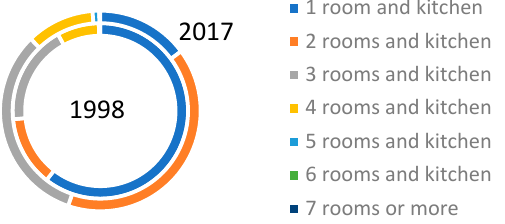
Figure 4. Apartments in new construction by type in Gothenburg region in 1998 and 2017.